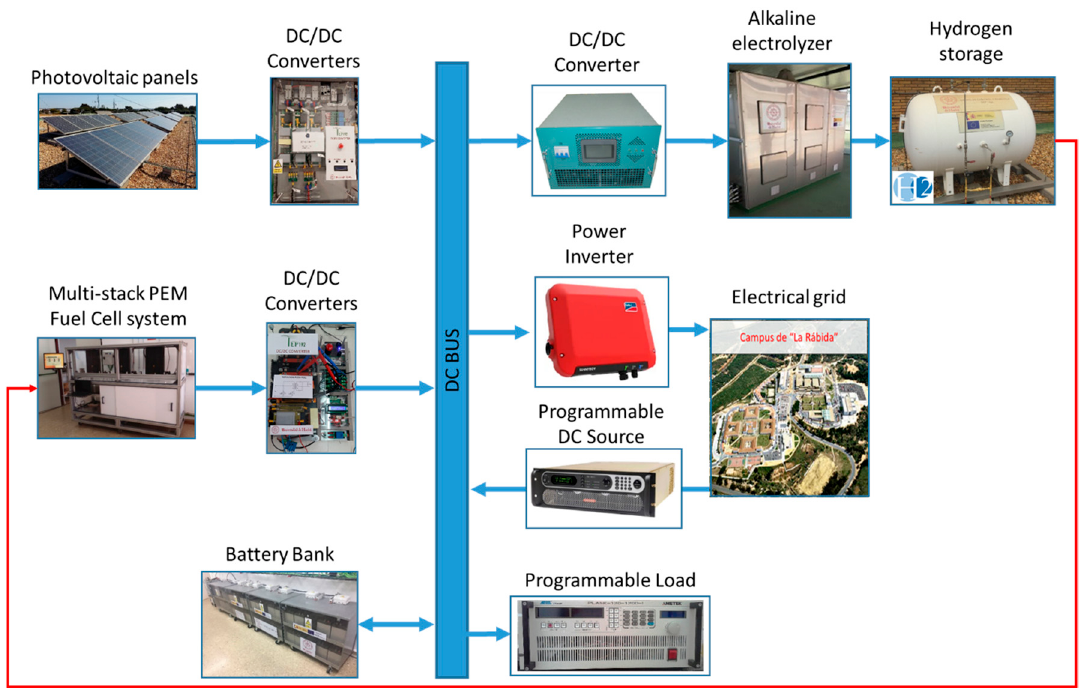
Figure 1. General microgrid architecture (University of Huelva).